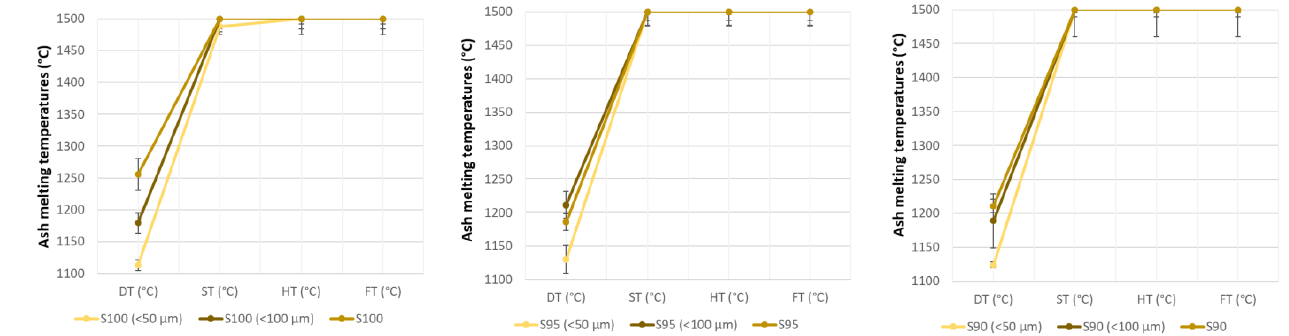
Figure 4. Differences in melting temperatures for spruce samples prepared at 550 °C.